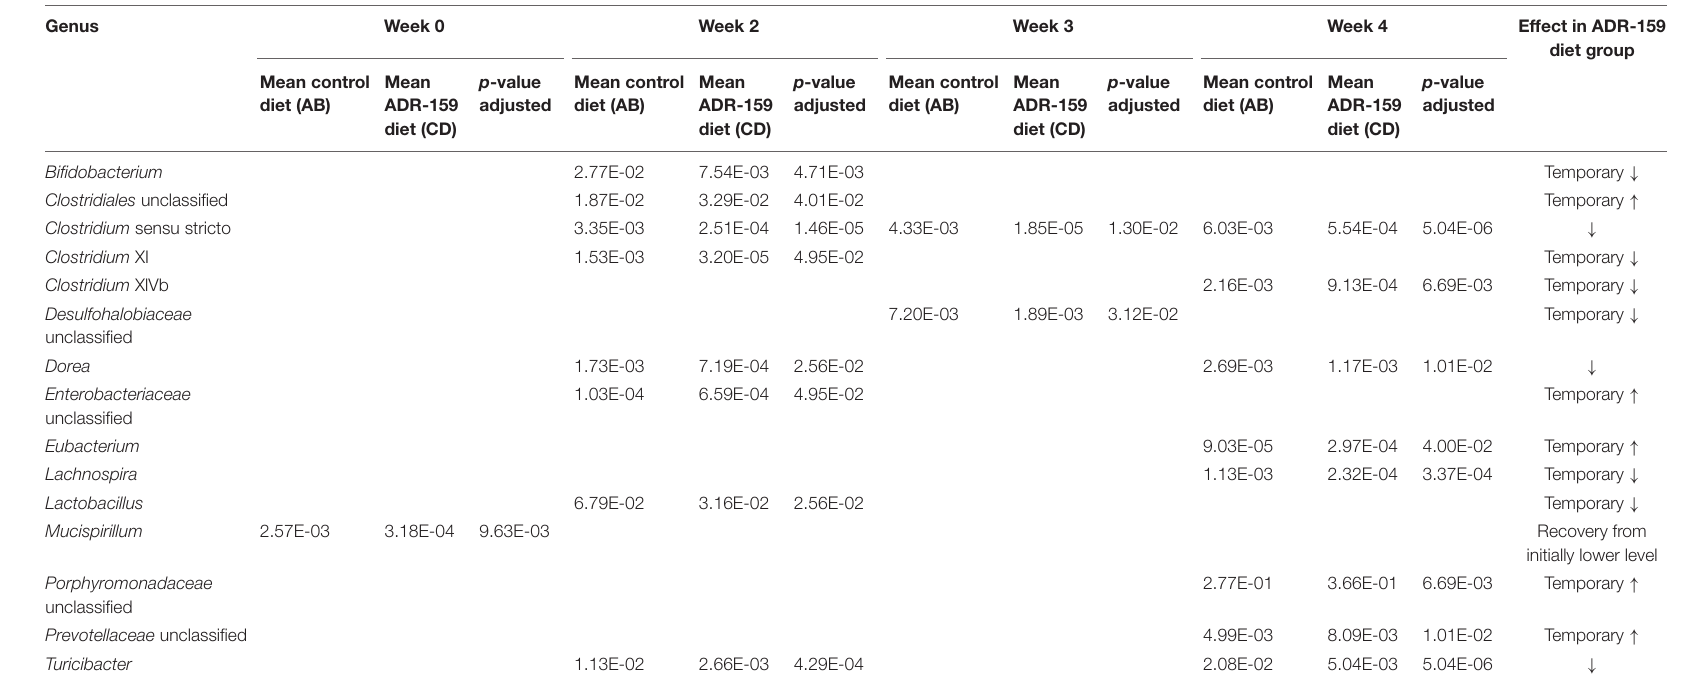
TABLE 1 | Genera differently abundant during 4 weeks of ADR-159 feeding compared to animals fed a standard diet.